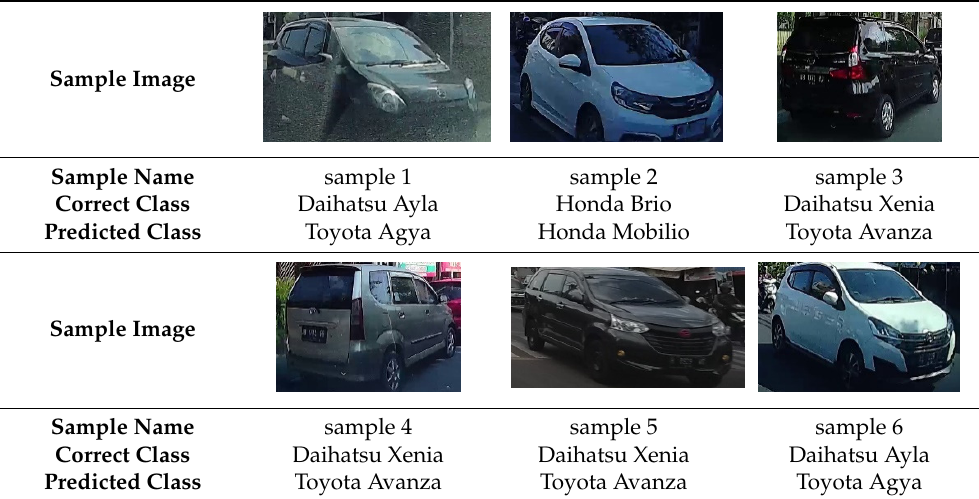
Table 9. Sample images that are incorrectly classified by the proposed method.